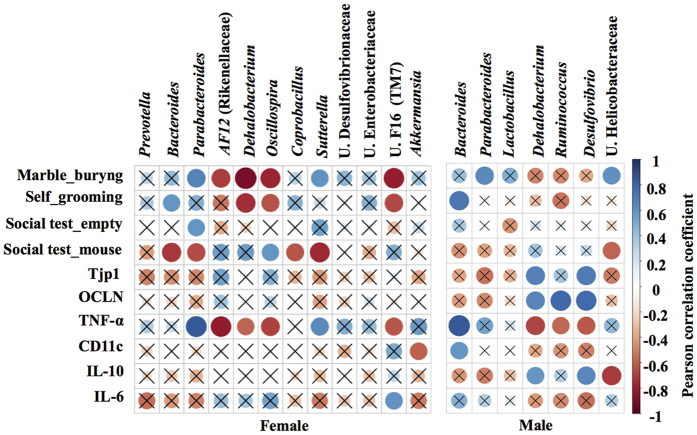
Correlogram showing the Pearson’s correlation between key genera and behavioral scores, gut integrity and immune-markers in BTBR and C57 mice of both sexes.Blue circles designate a positive correlation while red ones designate a negative correlation. With X are barred no significant results according to the significance level of 0.05.